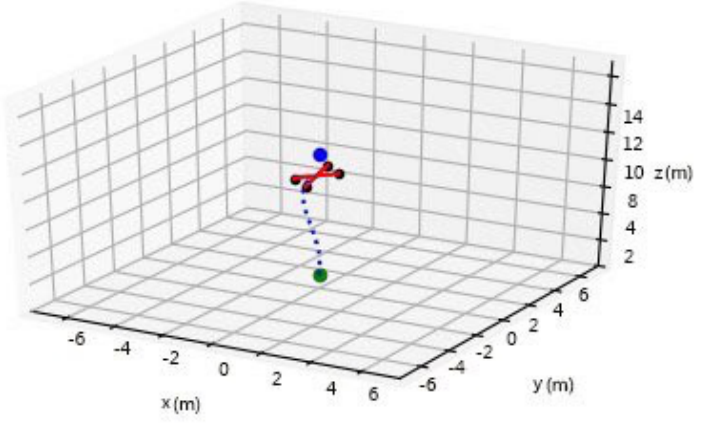
Figure 9. Waypoint navigation of drones using DDPG in